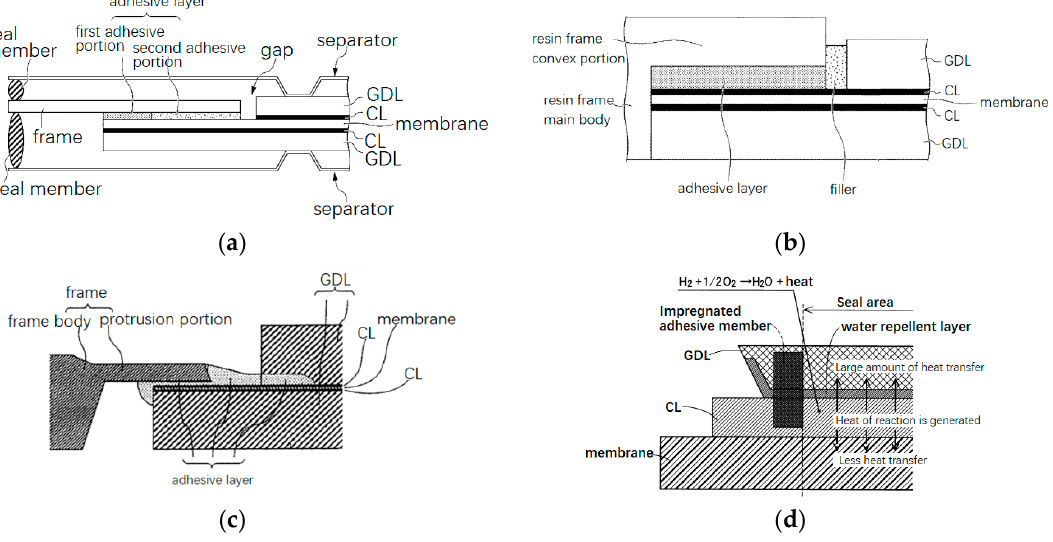
Figure 12. Measures to resist peeling and alleviate degradation in gaps: ( a ) two adhesives are used to bond the frame and MEA [98] ; ( b ) filler is applied at the gap [108] ; ( c ) adhesive covers gaps and edges of CCM [108] ; ( d ) adhesive is impregnated into the edge of MEA [90] .